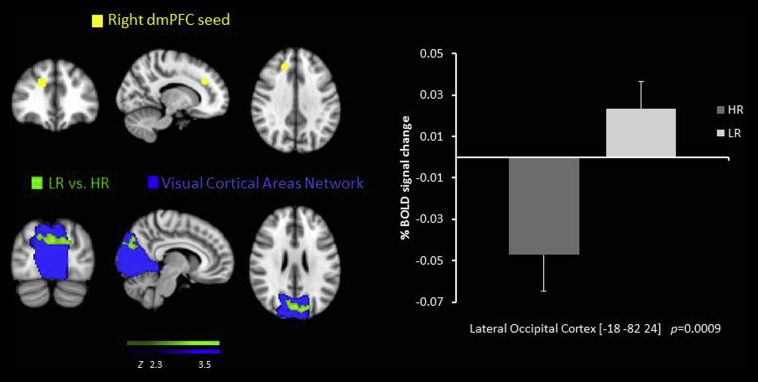
Resting state functional connectivity between the right dmPFC seed region  and the lateral occipital cortex, lower in the HR group than the LR  overlaid on the Visual Cortical Network . % BOLD signal change extracted for both of the groups.